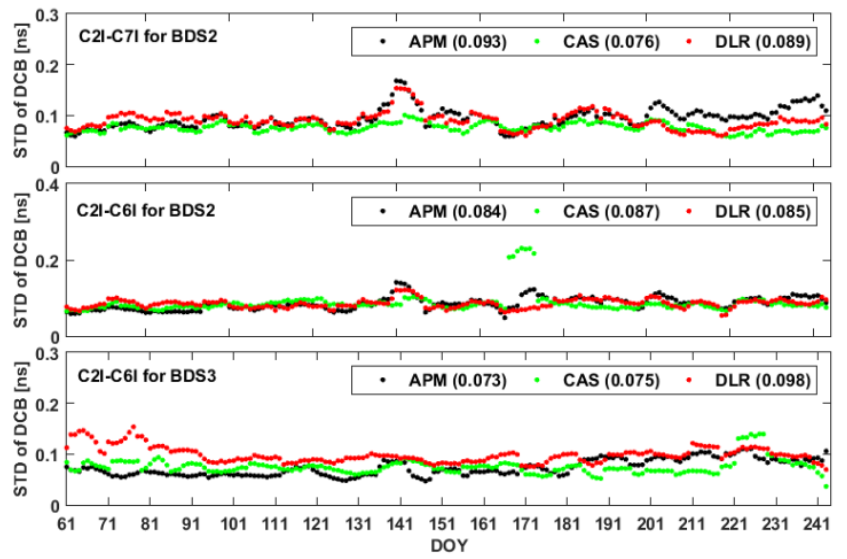
Figure 4. Weekly STDs of the C2I-C6I and C2I-C7I DCB estimates during the period of DOY 061–244 in 2020.